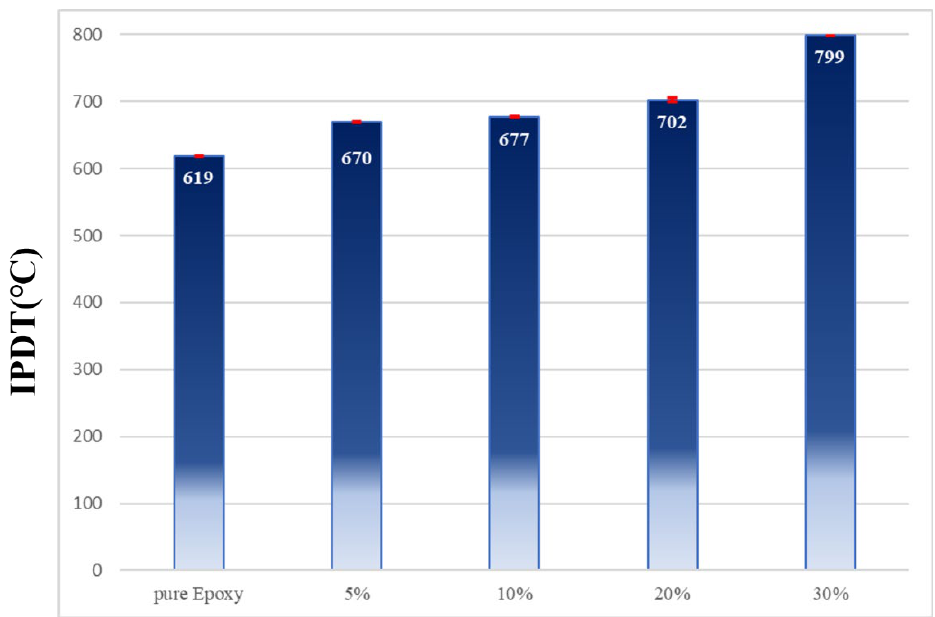
Figure 1. IPDT of pure Epoxy and Epoxy/Bagasse@TGIC@DOPO IPN composites.